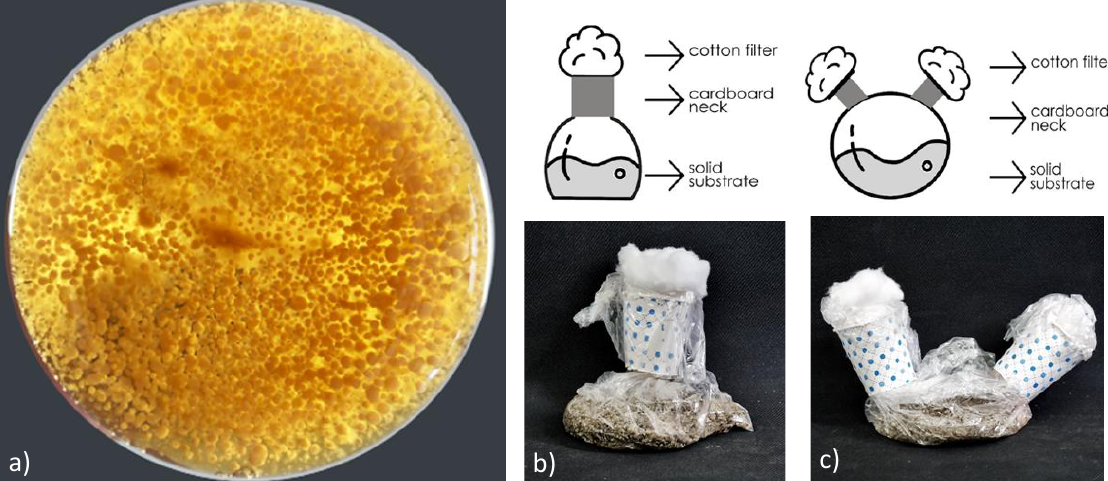
Figure 1. ( a ) Pellets (bottom the flask); ( b ) cotton-filtered bag container; ( c ) Candy-bag bioreactor (right). In order to see the effect of the system designed for biomass production, three candy bags were prepared for the MCB. One candy bag and one traditional bag were prepared as a control group. Both bags were filled with 200 g of zeolite support material and were enriched with a liquid solution containing mineral salts and nutrients (Table 2). Zeolite is an inert support material, consisting of SiO4 and/or AlO4, and is ideal for mycelium